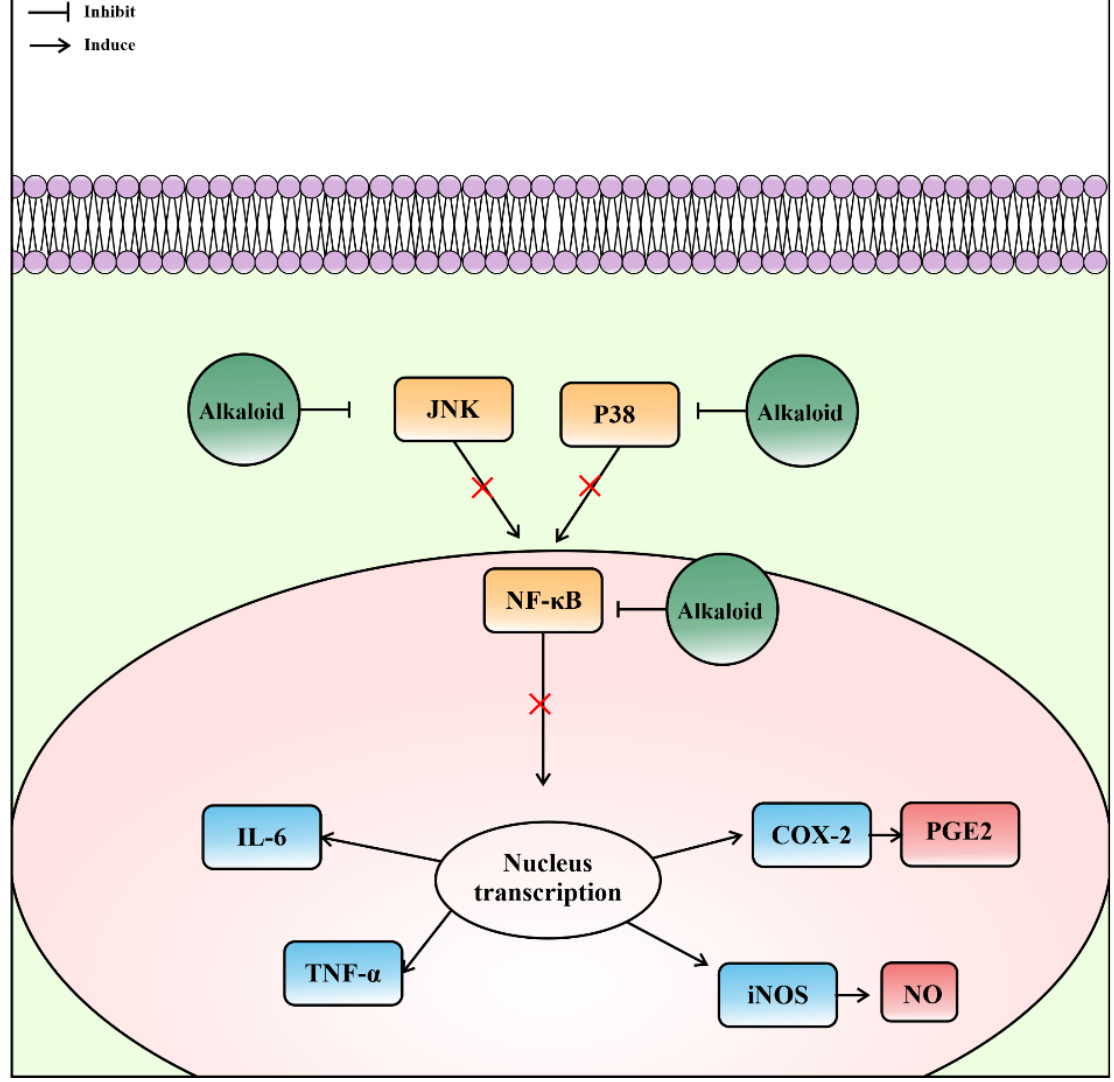
Figure 7. Prediction of anti-inflammatory mechanisms of alkaloids from the subgenus Callyspongia.